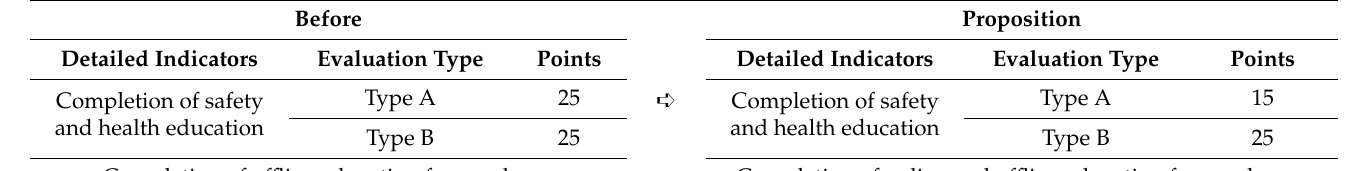
Table 9. Evaluation details for completion of safety and health education.